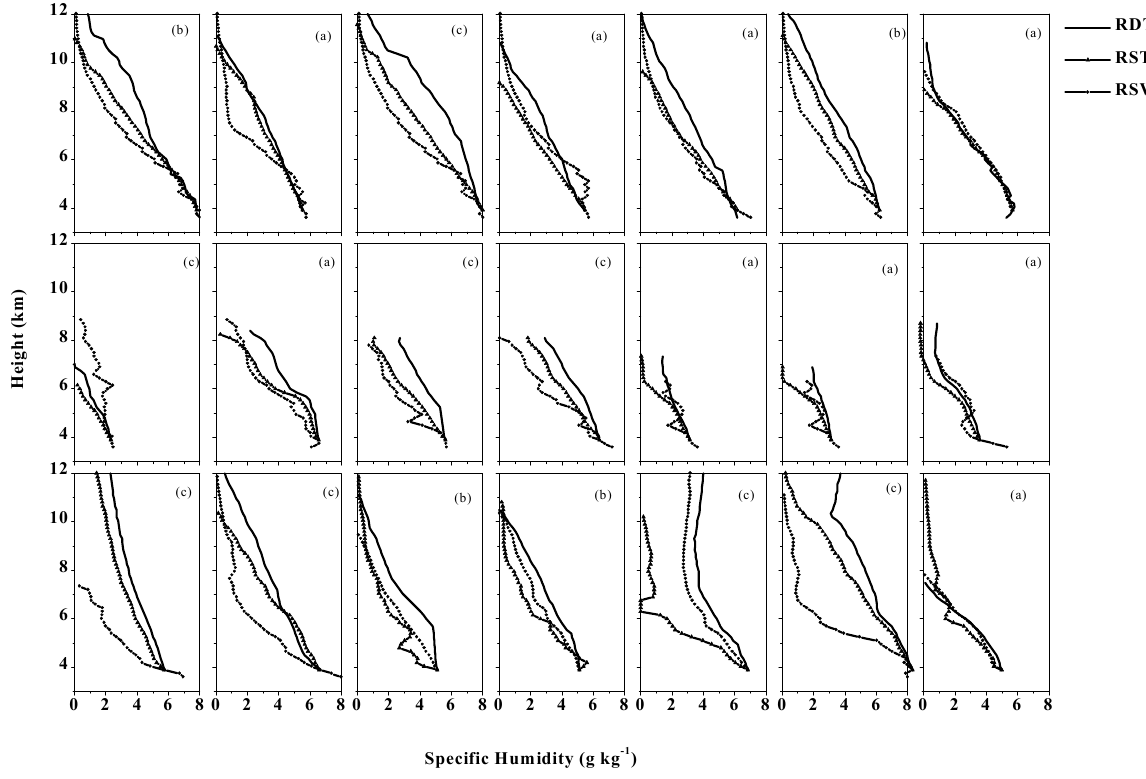
Fig. 6. Comparison of radar derived humidity profiles using radar derived temperature (RDT) with solid lines, radiosonde measured tem- perature (RST) profiles with downward sloping triangles and the humidity as measured by the radiosonde (RSW) with circles during the radar-radiosonde campaign period during July–August 1999. The labels indicate (a) clear (b) partly cloudy and (c) cloudy.